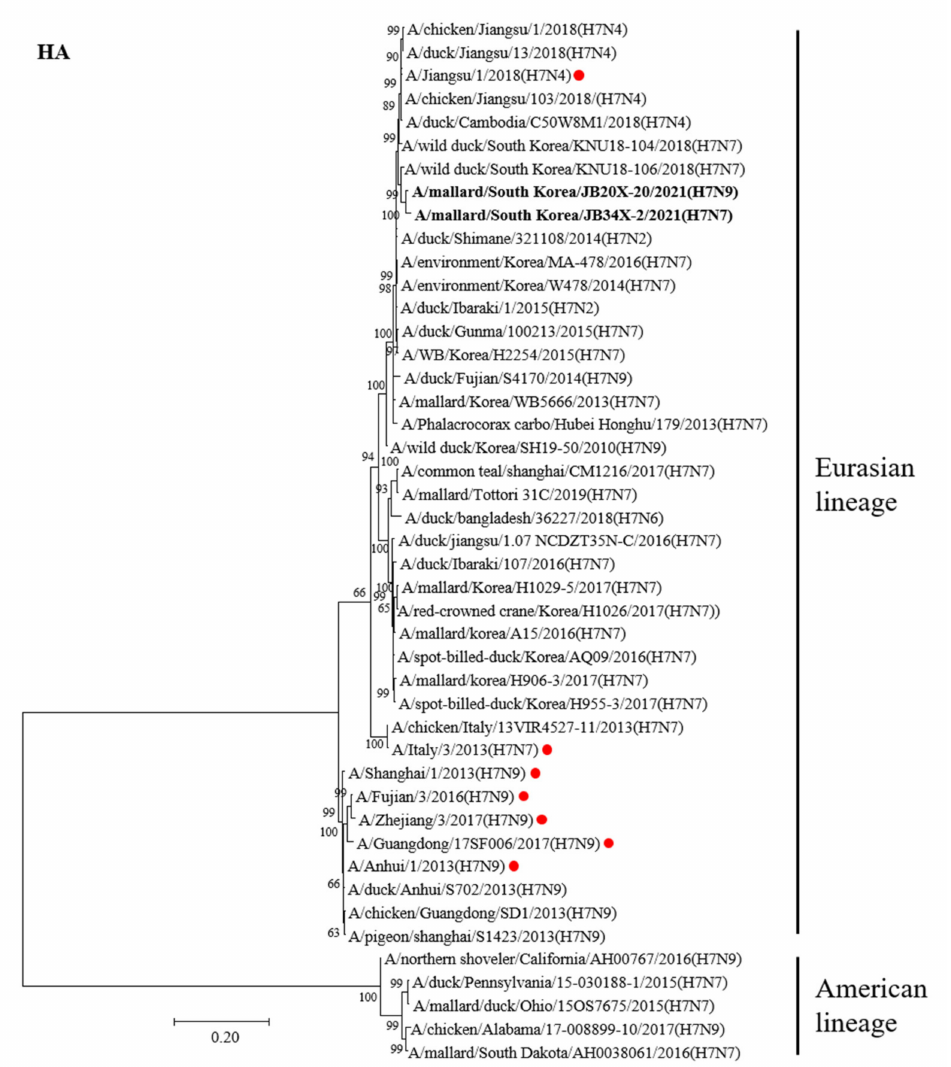
Figure 1. Phylogenetic tree of the HA gene of the H7 avian influenza virus (AIV) nucleotides. The tree was analyzed using the maximum-likelihood (ML) method with 1000 bootstrap replication and only bootstrap values more than 50% are shown. The two H7 Korea AIVs isolated in this study are shown in bold. The human influenza viruses are indicated by red